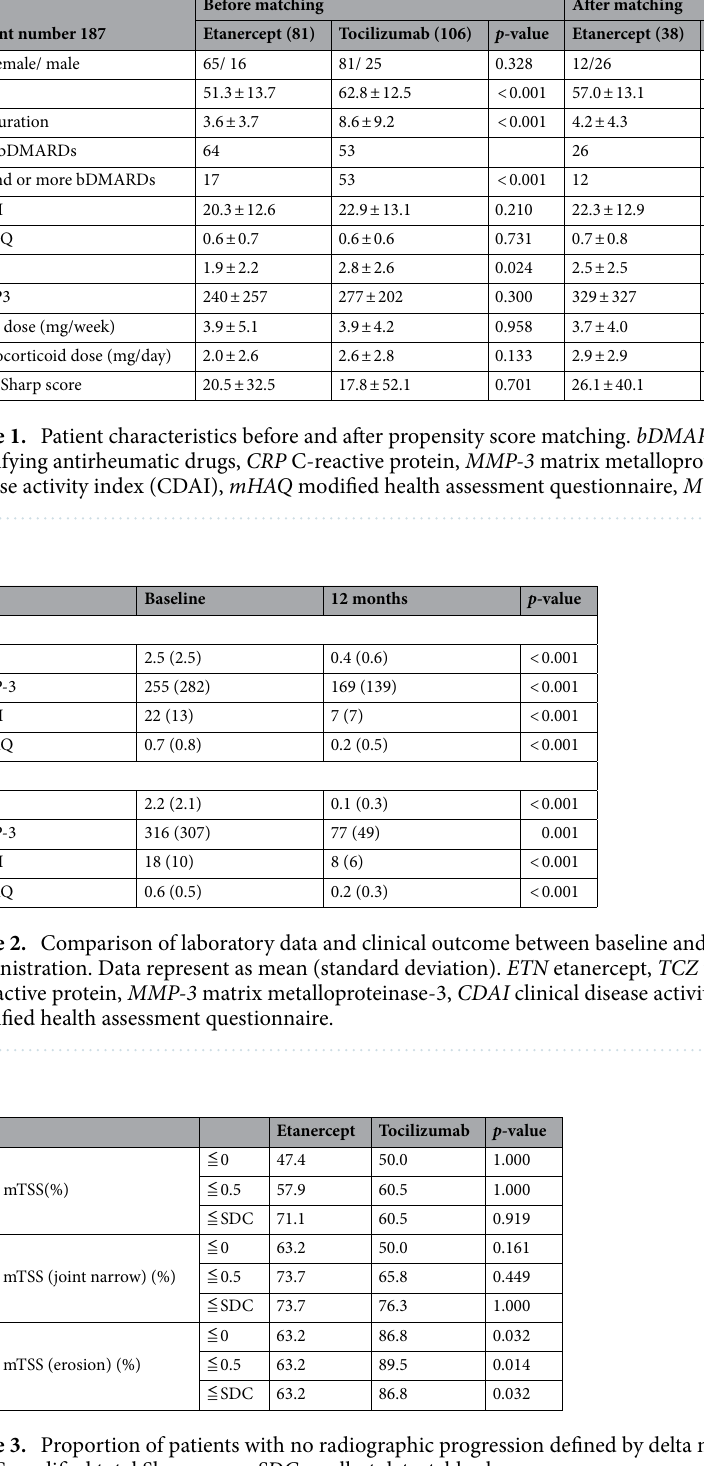
Table 3. Proportion of patients with no radiographic progression defined by delta mTSS ≤ 0, ≤ 0.5, and ≤ SDC. mTSS modified total Sharp score, SDC smallest detectable